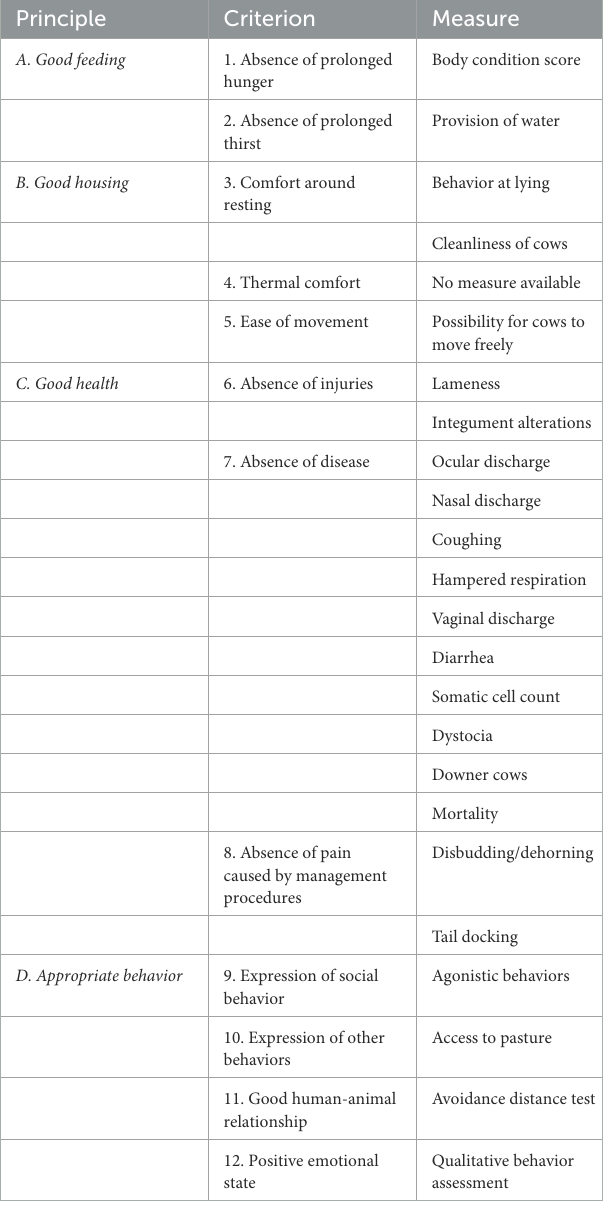
TABLE 1 Summary of the structure of Welfare Quality ® applied to dairy cattle including principles, criteria, and